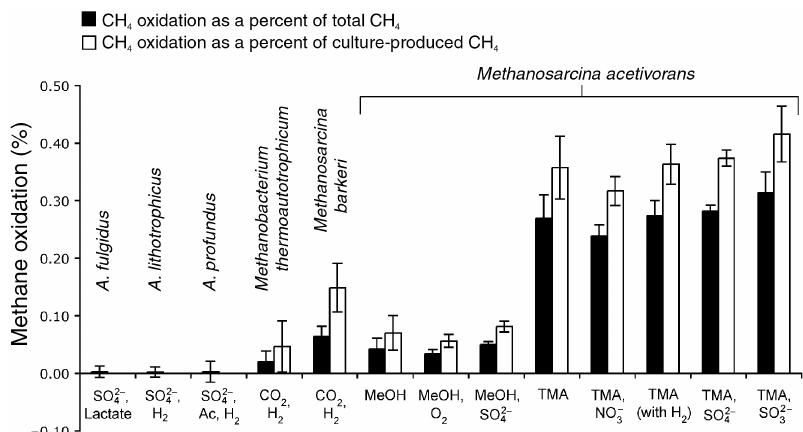
Figure 3. Methane oxidation (± 2 SD) stan- dardized to either the total amount of meth- ane in the culture after growth (black bars) or the methane produced by the culture dur- ing growth (white bars) observed in experi- ments with varying species and